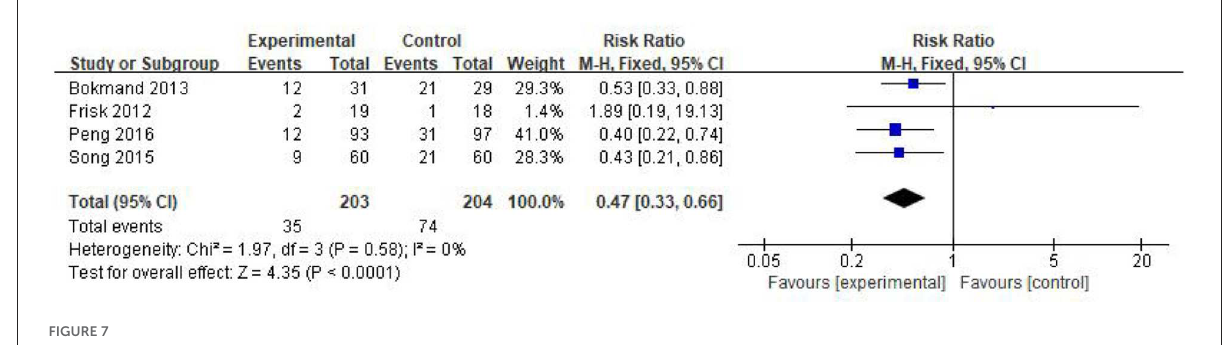
FIGURE7 Forest plot of dichotomous